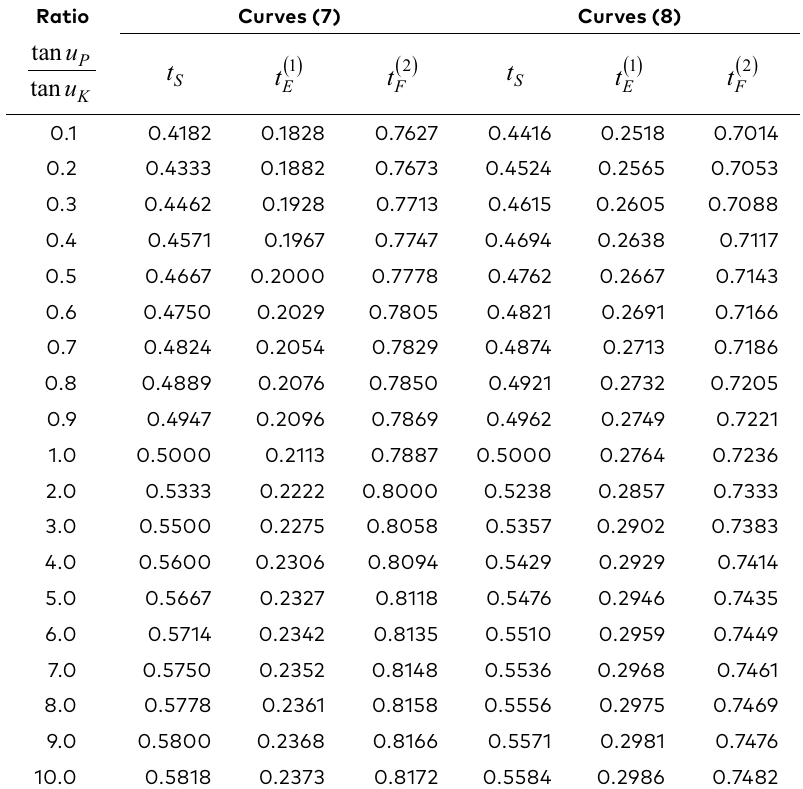
Table 1. Values of variable t describing the location of a curve inflexion point and extremes of derivative ′′